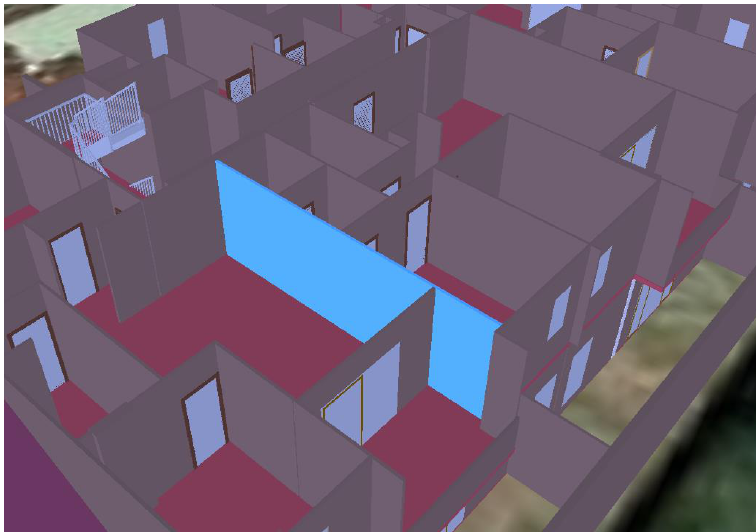
Figure 6. The highlighted wall is part of the Common Property No. 1 in this 3D model and due to the complexity in the 3D model, it is not shown as a legal object.